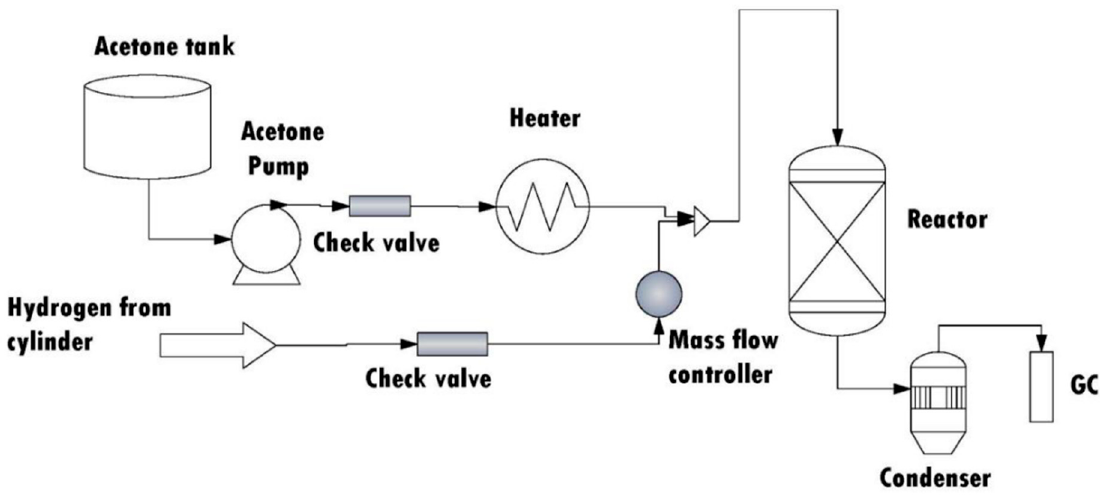
Figure 10. A simple schematic diagram of the experimental rig.